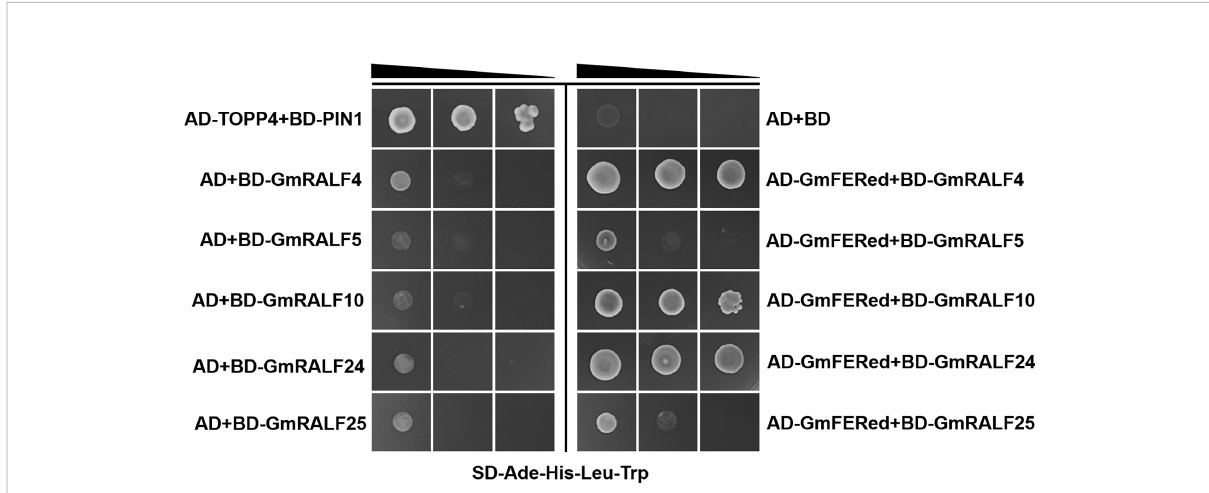
FIGURE 8 GmRALFs interacts with GmFERed in yeast. GmFERed interacts with GmRALF4, GmRALF10, or GmRALF24. GmRALF4 and GmRALF24 were removed from the signal peptide. The interaction between GmFERed and GmRALFs was tested on synthetic de fi ned medium without adenine, histidine, leucine, and tryptophan (SD-Ade-His-Leu-His). Serial dilutions of the yeast colonies were plated. The experiment was repeated three times with similar